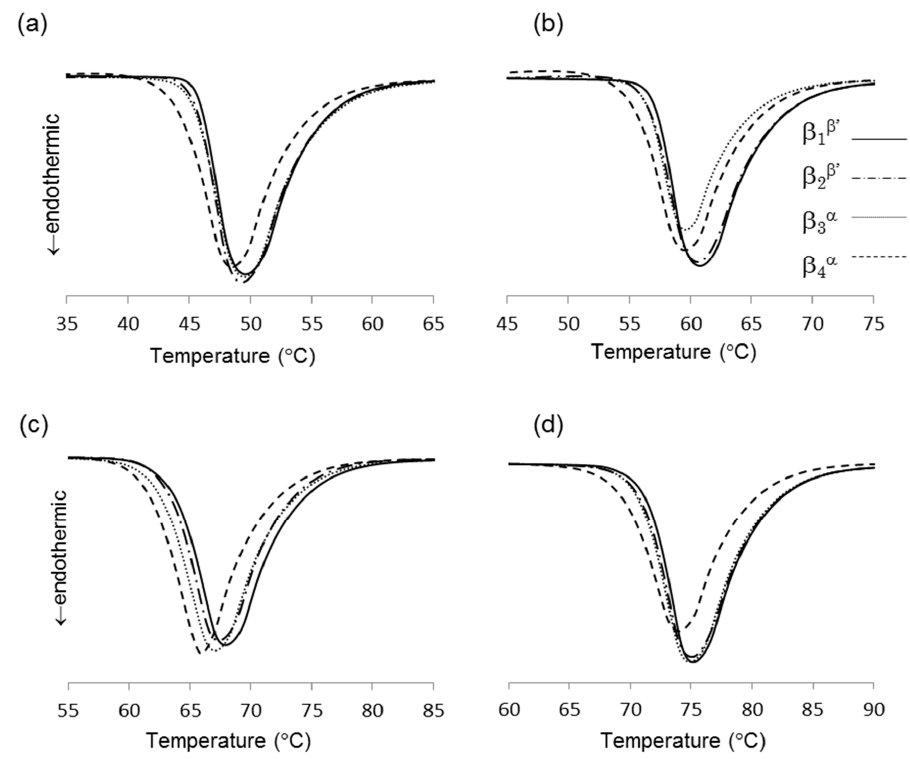
Figure 3. Thermograms of four β forms of saturated monoacid triacylglycerols (TAGs), ( a ) trilaurin, ( b ) trimyristin, ( c ) tripalmitin, and ( d ) tristearin. Table 1. Melting points (°C) of the multiple β forms of TAG.